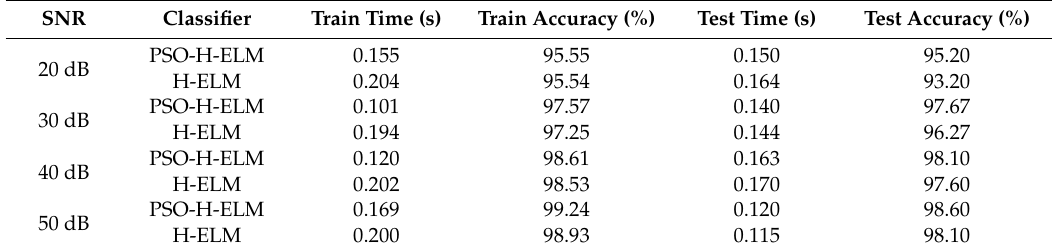
Table 5. Comparison between the PSO-H-ELM and H-ELM